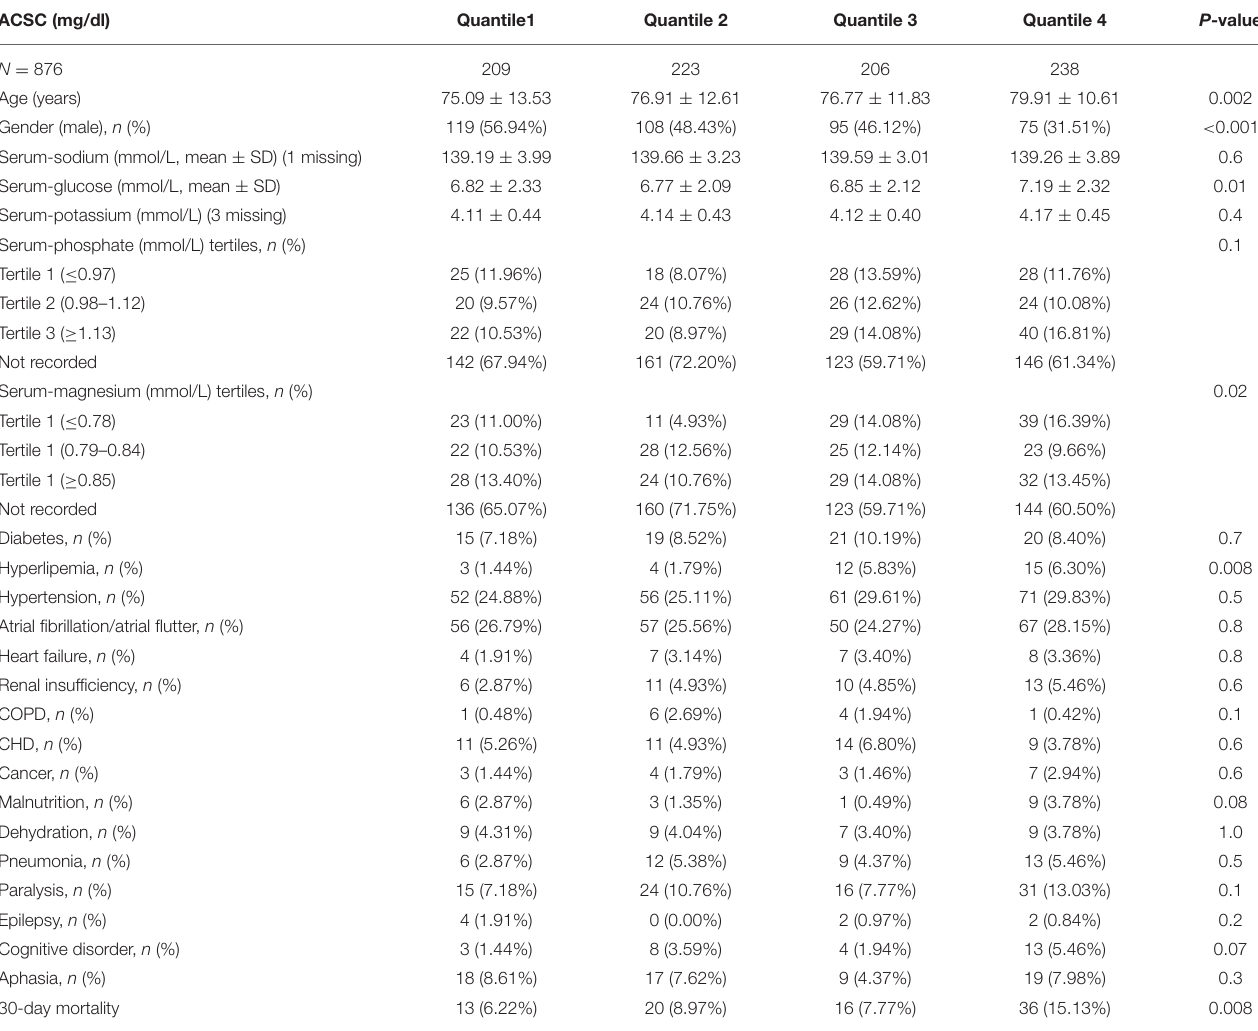
TABLE 1 | Baseline characteristics of the patients according to quartiles of ACSC level.